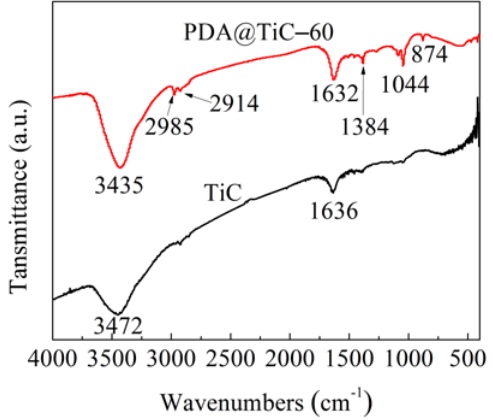
Figure 1. FTIR spectra of TiC and PDA@TiC − 60.